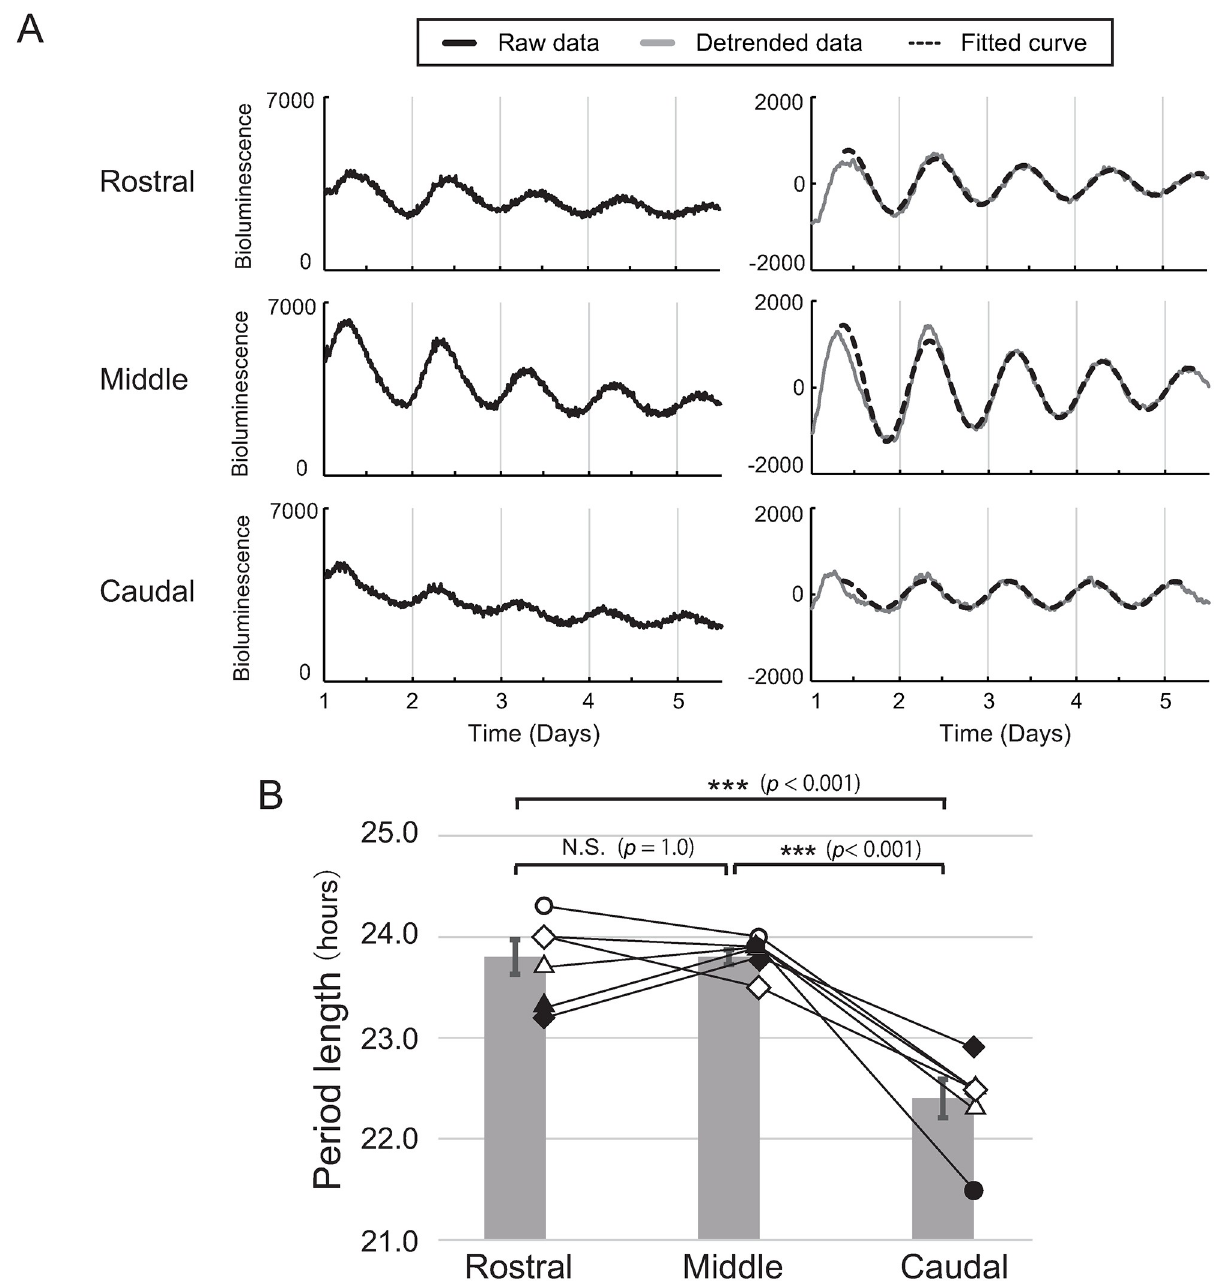
Fig 2. Per2 ::dLuc bioluminescence rhythm in coronal slices of the SCN measured by PMT. (A) Representative Per2 ::dLuc bioluminescence rhythm from consecutive slices of a single individual animal (Rostral, Middle, and Caudal). Left and right panels show raw data and detrended data, respectively. (B) Circadian periods from Rostral, Middle, and Caudal (Mean ± SE). The periods of each slice are superimposed. Period data from the same individuals are connected by lines. Repeated measures one-way ANOVA with Post-hoc Bonferroni test. ��� : p < 0.001 vs Rostral and Middle, N. S.: not